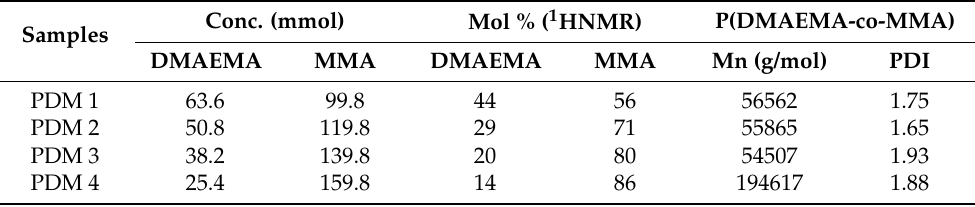
Table 1. Concentration, molar %, average molecular mass (Mn) and polydispersity index of copoly- mers P(DMAEMA-co-MMA) samples PDM1, PDM2, PDM3 and PDM4 with different molar concen- tration of DMAEMA and